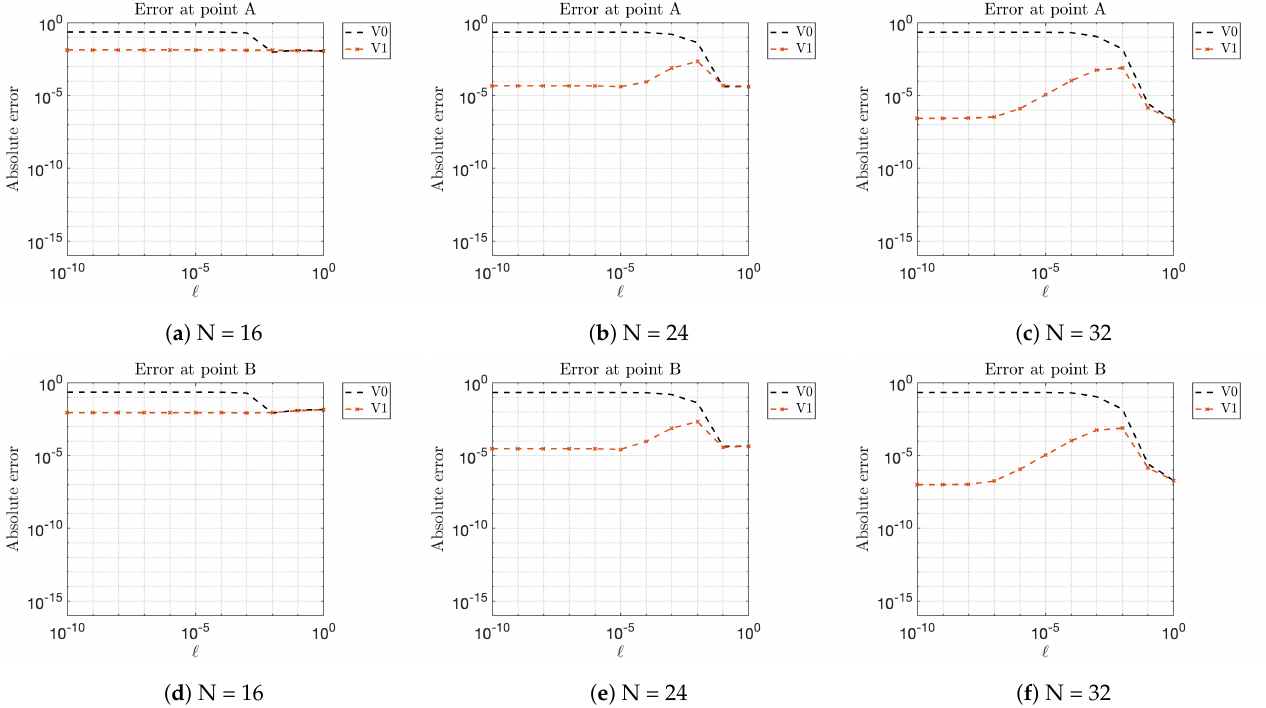
Figure 9. Helmholtz 3D. Log-Log of the error along the normal for the evaluation of the solution of (18) out of the ellipsoid parameterized by y ( s , t ) = ( 2cos ( t ) sin ( s ) ,sin ( t ) sin ( s ) ,2cos ( s )) , ( s , t ) ∈ [ 0, π ] × [ − π , π ] , for the